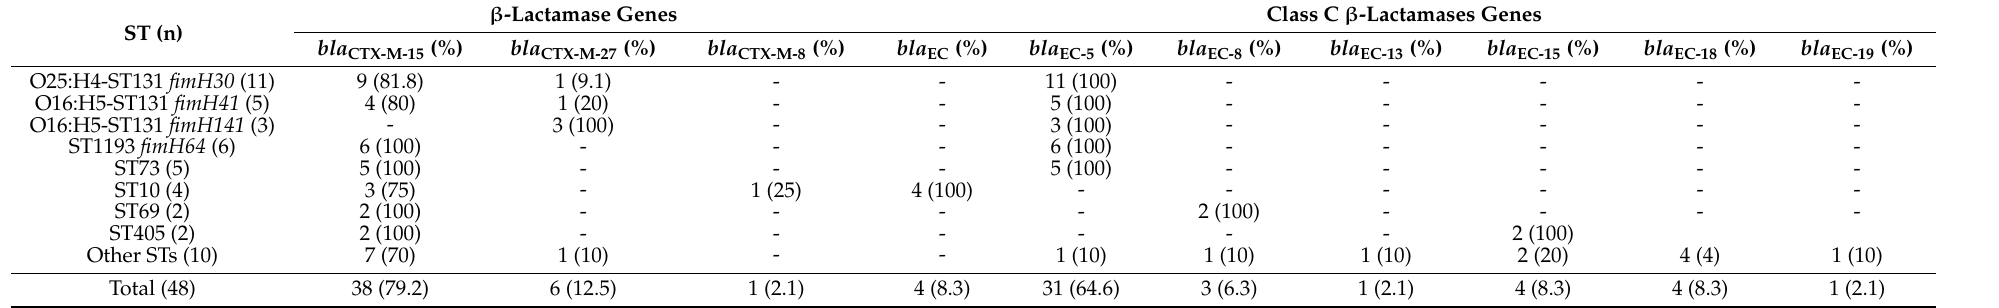
Table 3. Sequence types and prevalence of β -lactamases genes identified in UPEC isolates from this study.